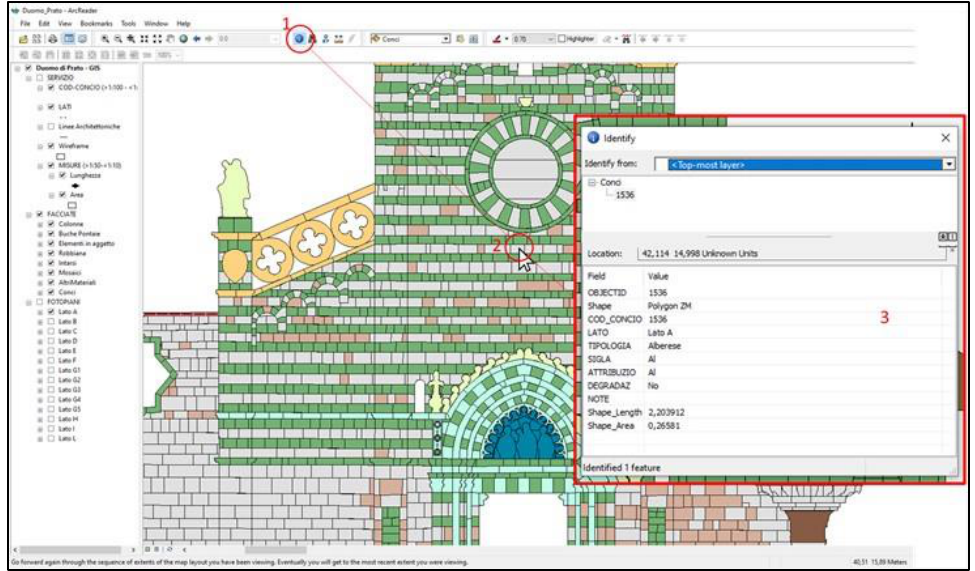
Figure 4. Examples of the Cathedral and Bell-Tower GIS implementation, the main display environ- ment and query example for the façade.